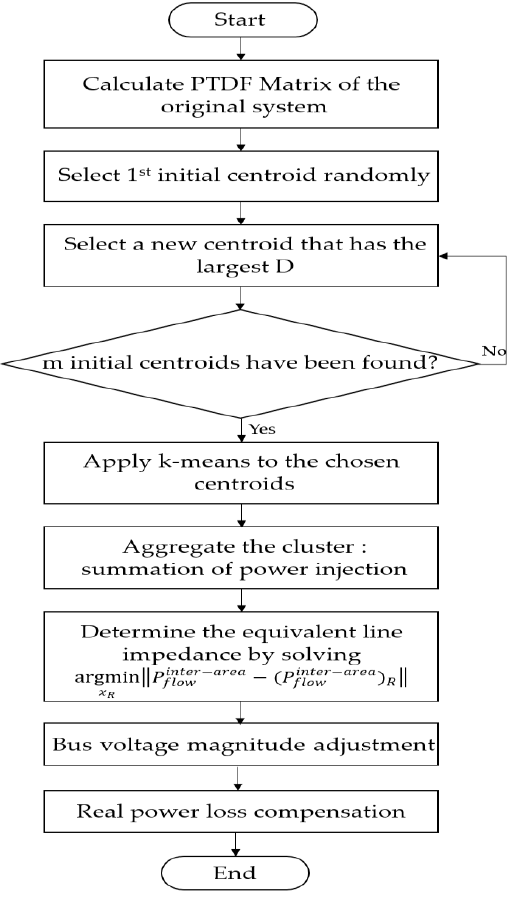
Figure 3. Flowchart for developing the equivalent model.